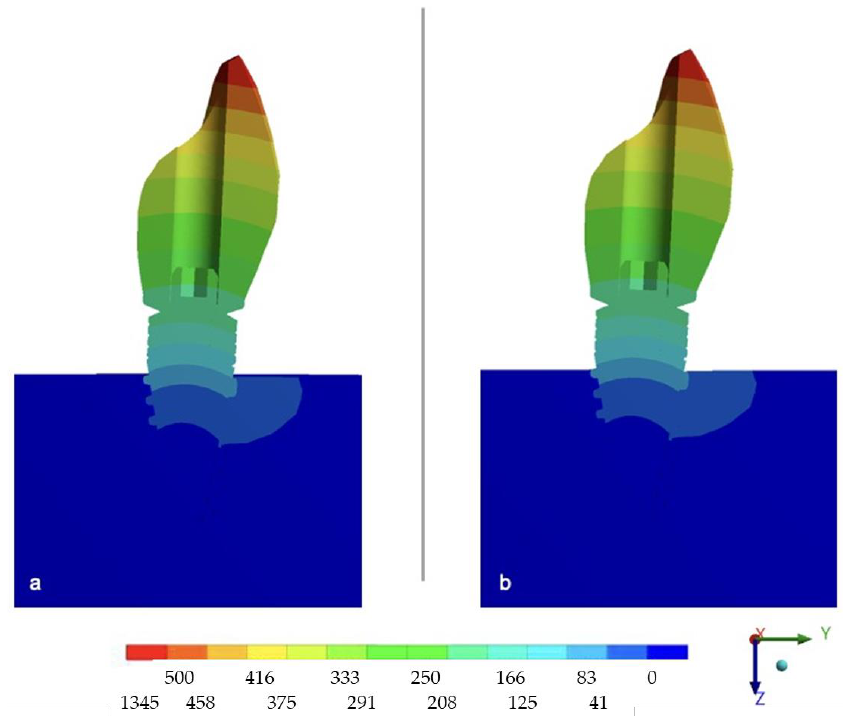
Figure 10. The maximum displacement of the assembly with the short abutment ( a ), and the long abutment ( b